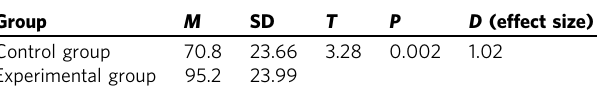
Table 2 Descriptive and inferential statistics for the two groups in the interview test.